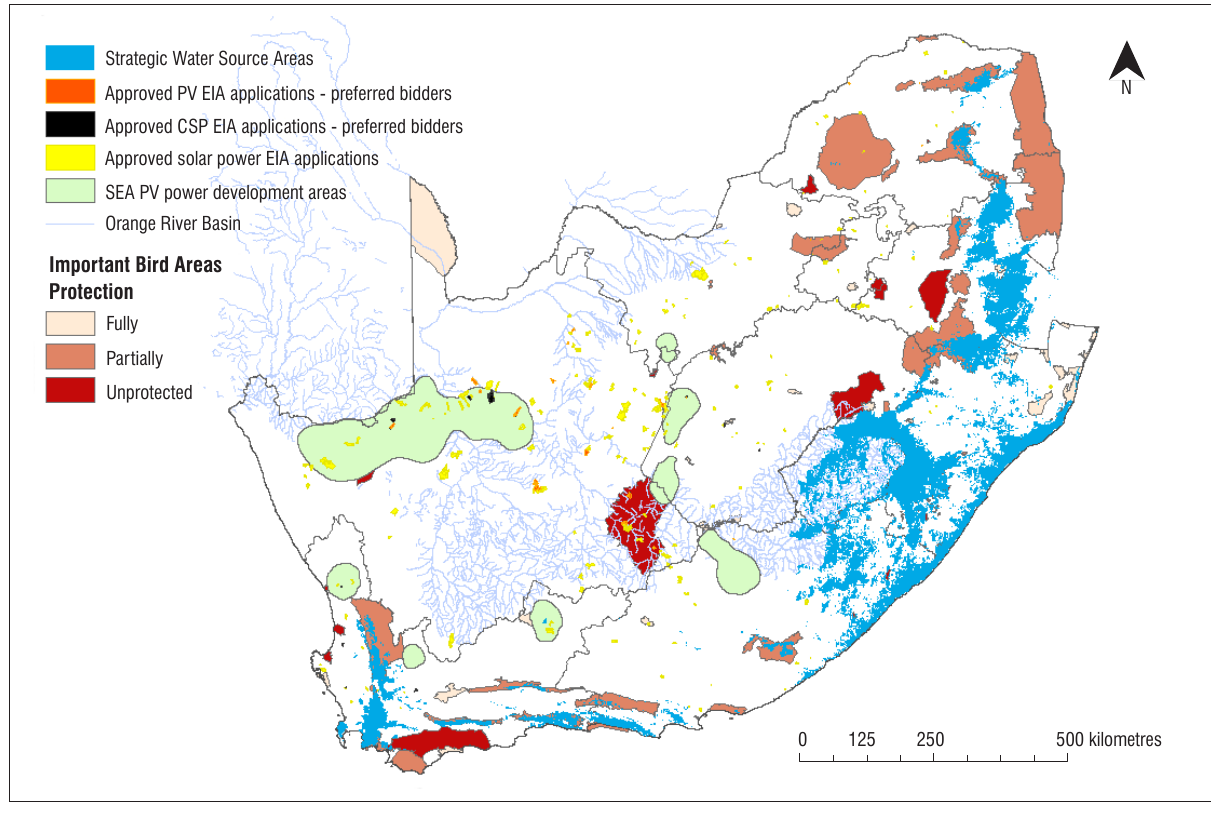
A map of South Africa showing national strategic water source areas and photovoltaic (PV) power Renewable Energy Development Zones. Areas with approved solar power environmental impact assessment (EIA) applications and the following protected or sensitive biodiversity areas are shown for the Nama-Karoo and Savanna Biomes only: Important Bird Areas, South Africa’s Protected Areas and National Protected Areas Expansion Strategy focus